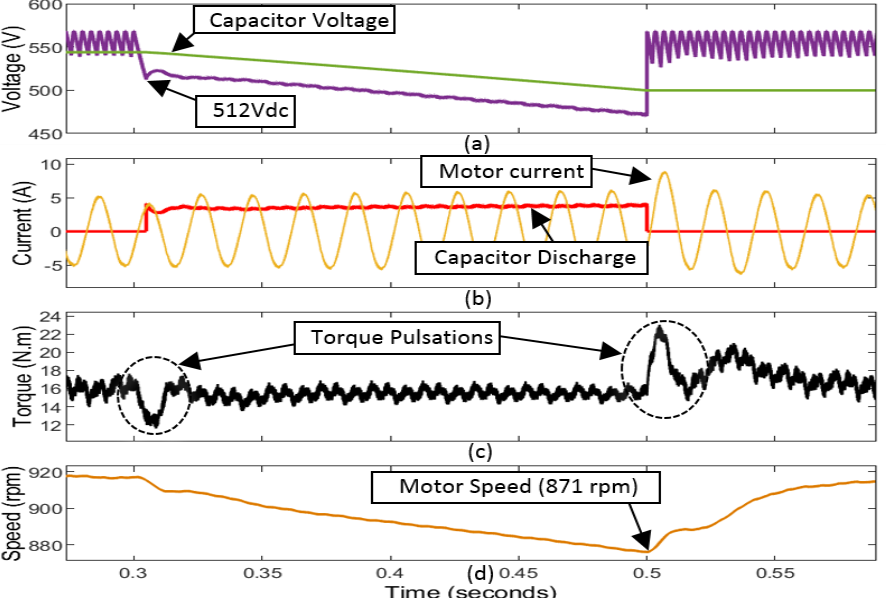
Figure 8. Simulation results with dc-link voltage compensation, ( a ) dc-link and capacitor voltage, ( b ) Motor and capacitor discharge current ( c ) torque and ( d ) speed response.